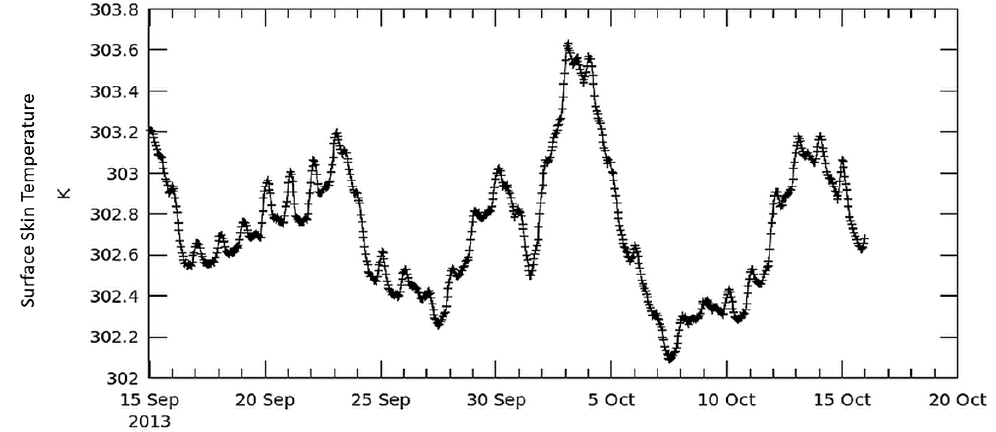
Figure 5. Time series of MERRA-2 SSkT data for the Chuuk Lagoon region for the period 15 Sep-